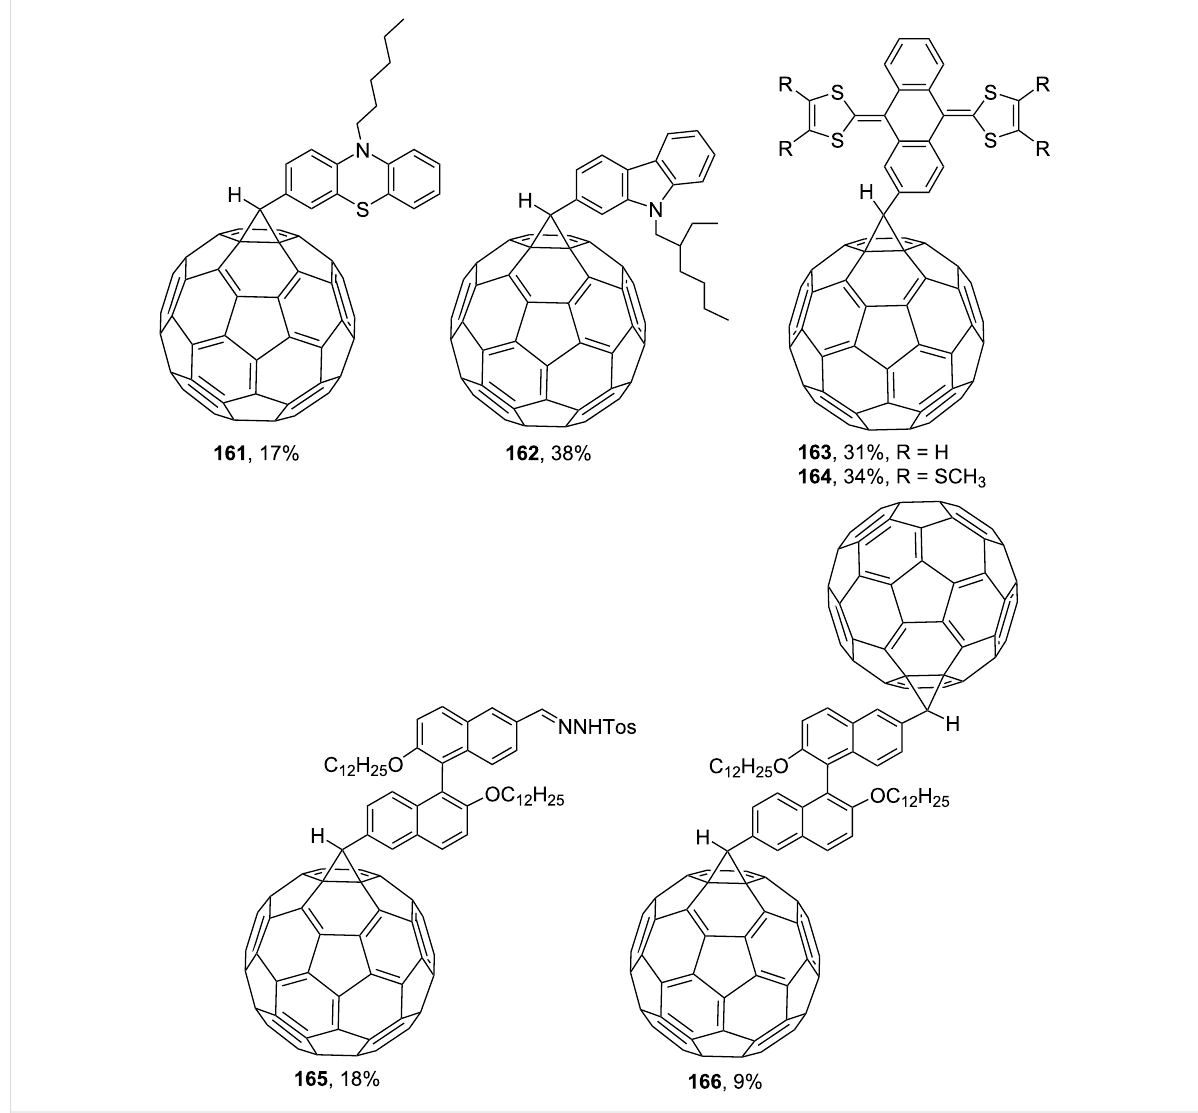
Figure 10: Structures of methanofullerenes containing aromatic polycyclic systems.